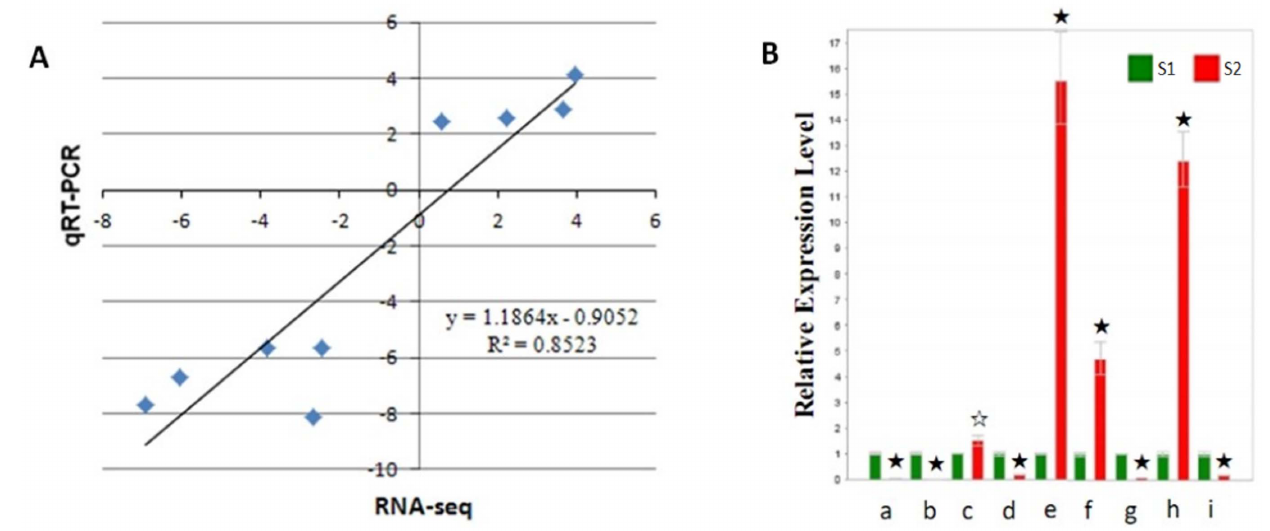
Figure 6. qRT-PCR validation of differentially expressed genes between the two pericarp pools of sand pear. A, Correlation of fold change analyzed by RNA-Seq platform (x axis) with data obtained using real-time PCR (y axis). B, Expression analysis of the 9 differentially expressing unigenes revealed by RNA-seq assessed through qRT-PCR. S1 and S2 represent the sand pear pericarp pools of 80 DAP the green- (S1) and the russet- pericarp fruits (S2), respectively. The expression level of these unigenes in S1 was normalized to be the same. a , i represent the 9 differentially expressing unigenes, i.e. a, GALR01005880; b, GALR01015948; c, GALR01006906; d, GALR01012212; e, GALR01009736; f, GALR01010946; g, GALR01016595; h, GALR01020254 and i, GALR01020707, respectively (Table S1 in File S1). Error bars represent SE (n=3). Asterisks indicate levels of significance of differential expression (t test: q , P , 0.05; w , P , 0.01).